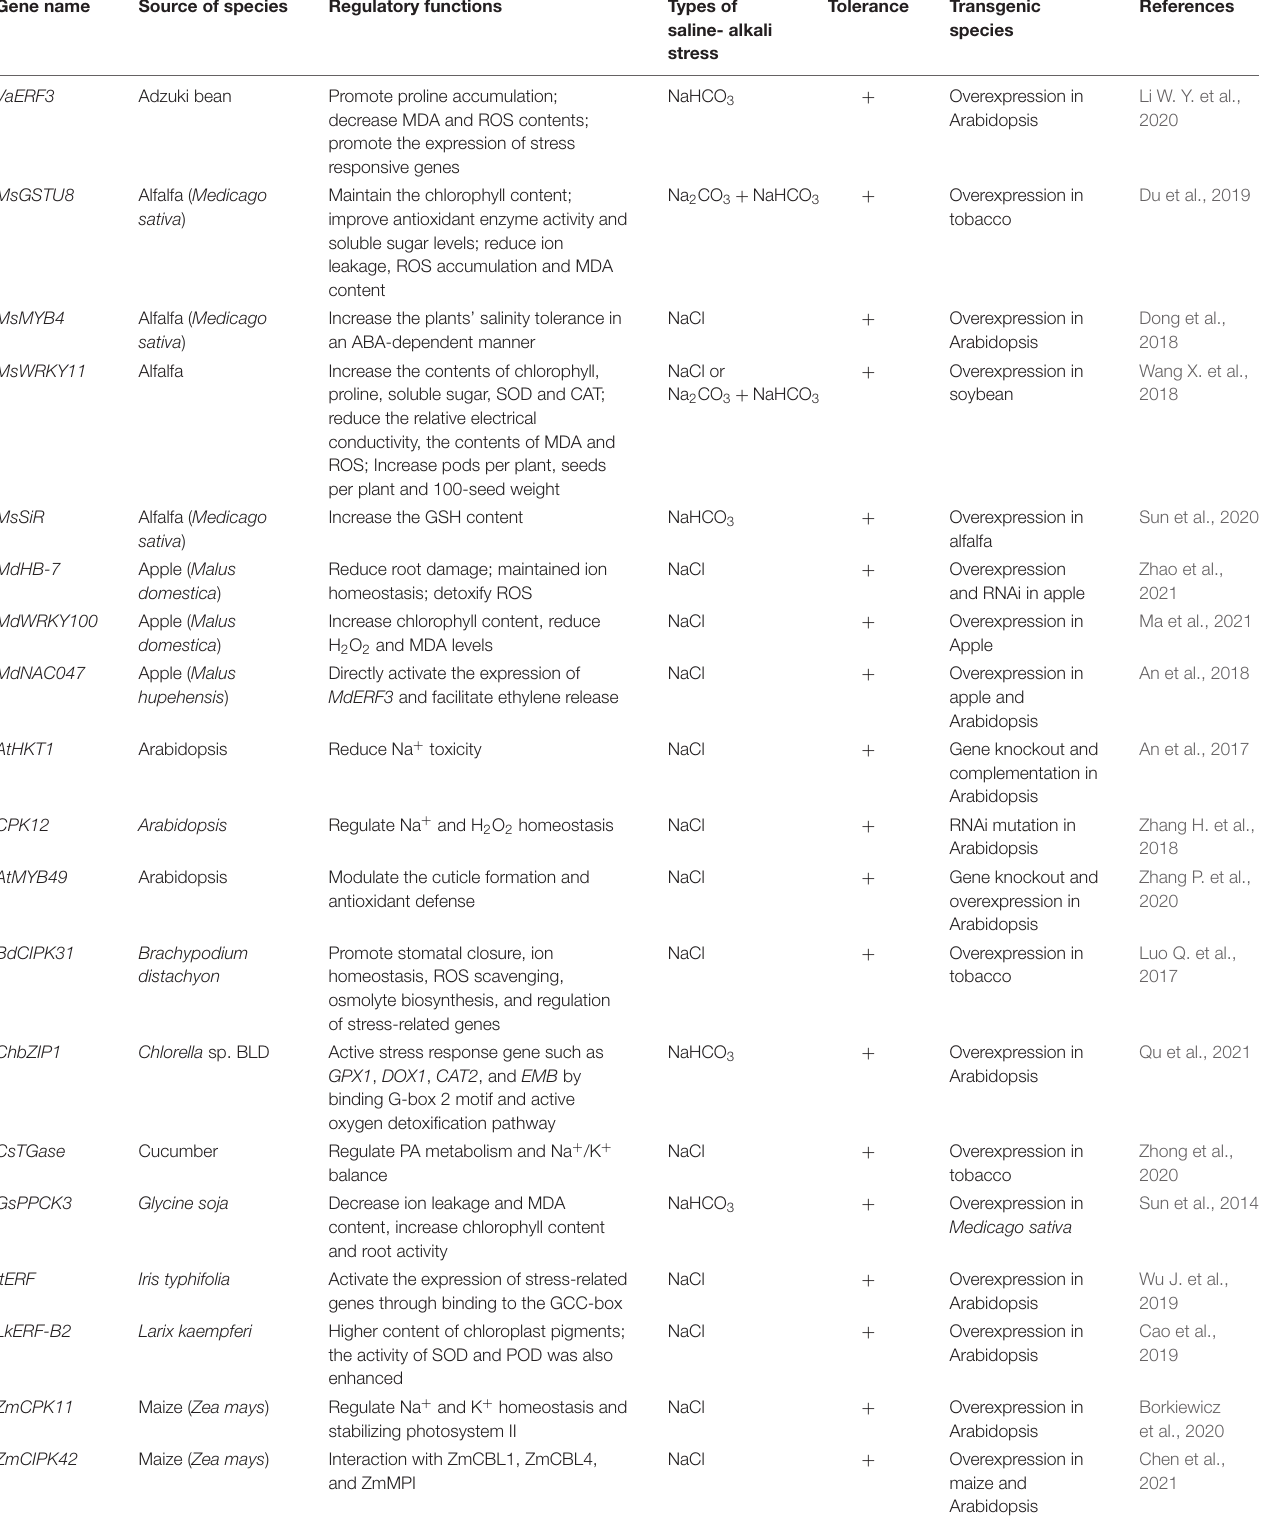
TABLE 1 | List of genes associated with salinity and alkalinity adversity response in